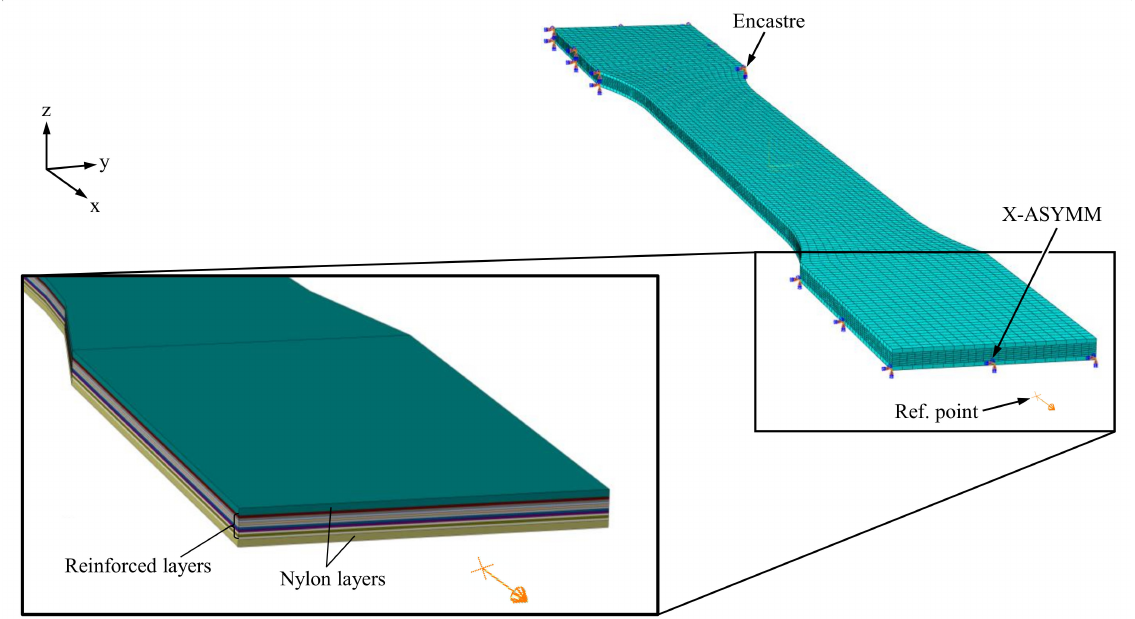
Figure 8. Meshing and constraint conditions of the FE model with a section of the FE shell model with the assigned thicknesses of the shell